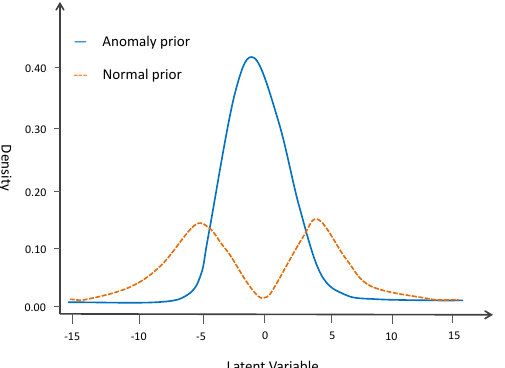
Figure 2. Data density distribution in hidden space for normal and abnormal data.